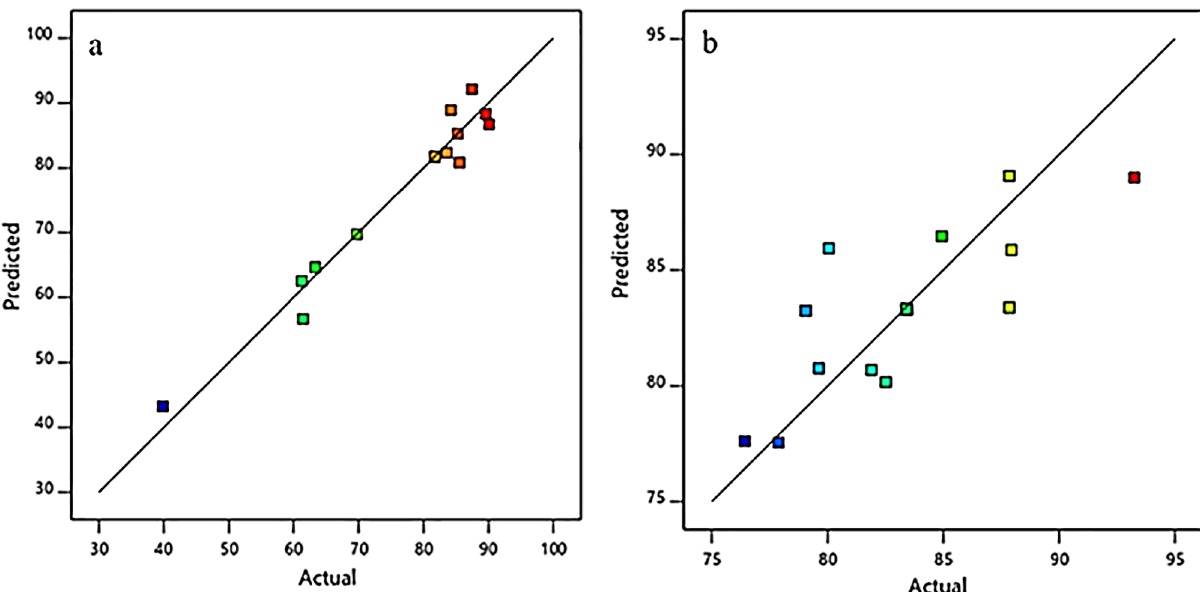
Figure 12. The comparison of predicted value against the actual value by the RSM in rapeseed oil ( a ) and waste corn oil ( b